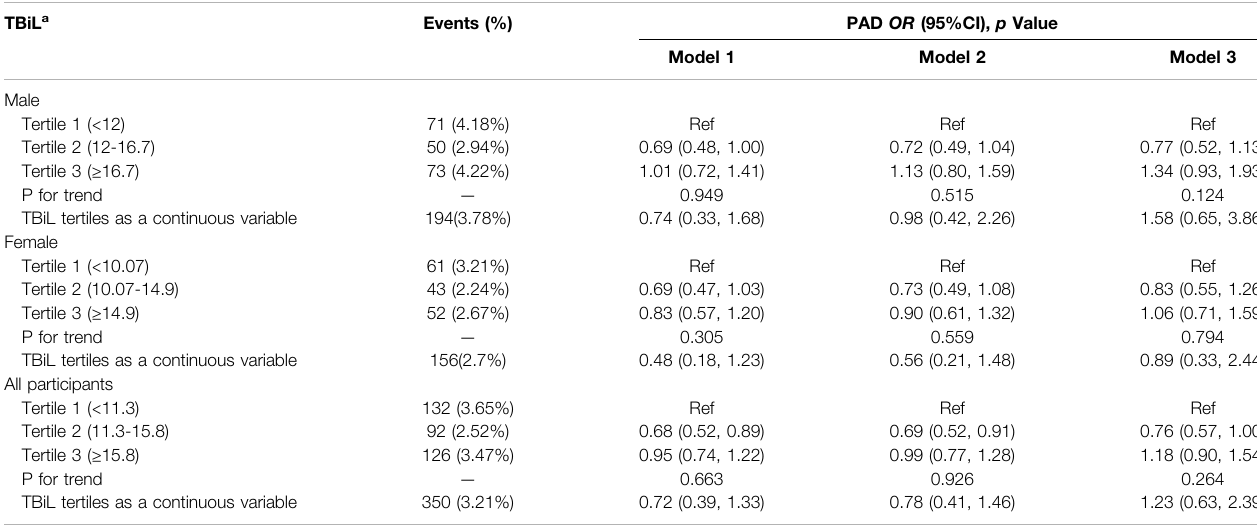
TABLE 2 | ORs and 95% CI of PAD incidence according to TBiL levels ( μ